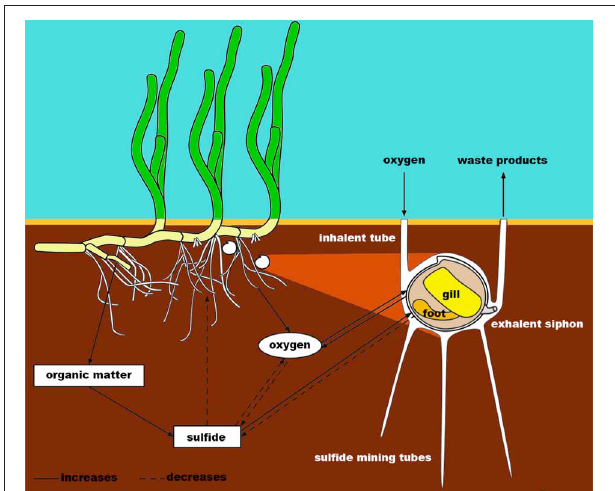
FIGURE 4 | Sulfide-driven coevolution: tripartite mutualistic interactions among seagrasses, lucinid bivalvesand sulfide oxidizing bacteria in their gills generate a higher fitness of all species involved under sulfidic conditions. See text for explaining mechanisms. Adapted after Van der Heide et al.